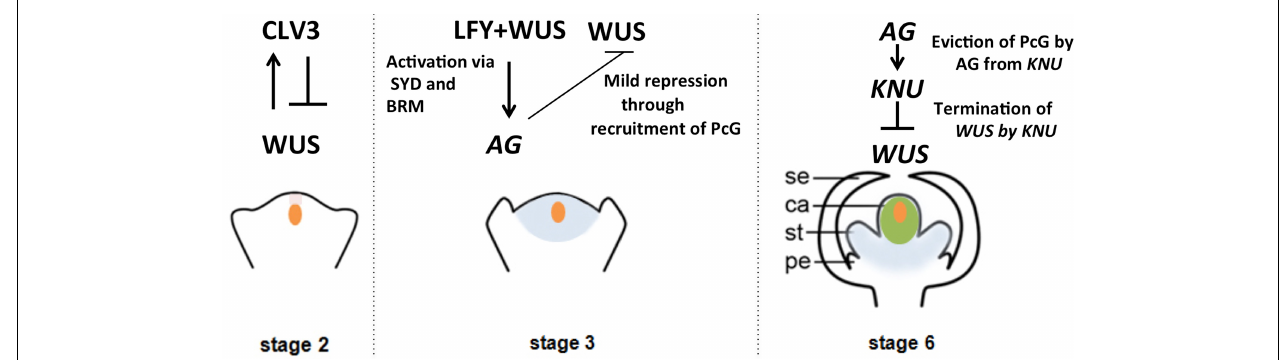
FIGURE 1 | Regulation of the timing of floral stem cell termination. Signaling cascades, transcriptional regulation and epigenetic regulation of the key proteins involved in floral meristem regulation are illustrated in a